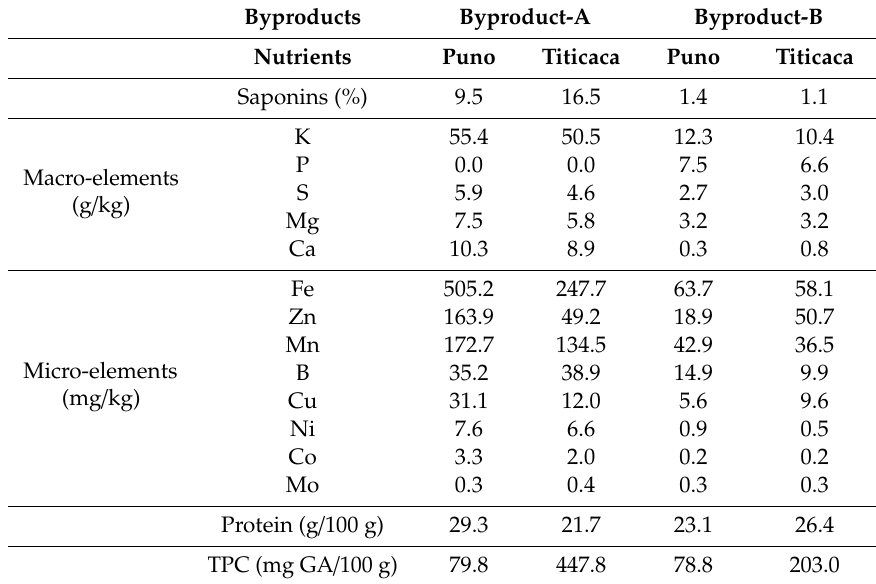
Table 2. Estimated content of saponins, minerals, proteins and Total Phenolic Compounds (TPC) in quinoa production line byproducts (Bp) by variety. Byproducts Byproduct-A